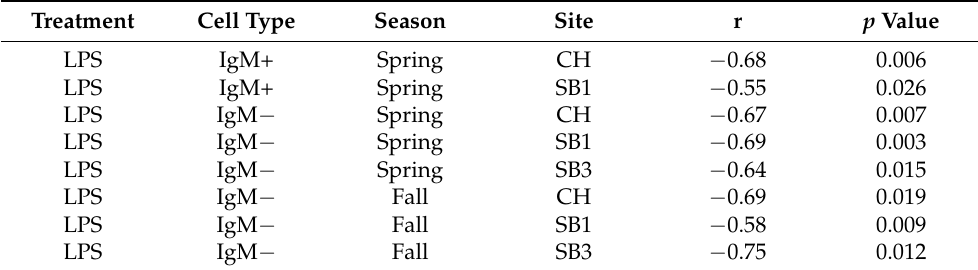
Table 1. Correlations between unstimulated background mitogenesis and LPS-stimulated mitogenesis. Spearman correlation method. Only significant results ( p ≤ 0.05) displayed.